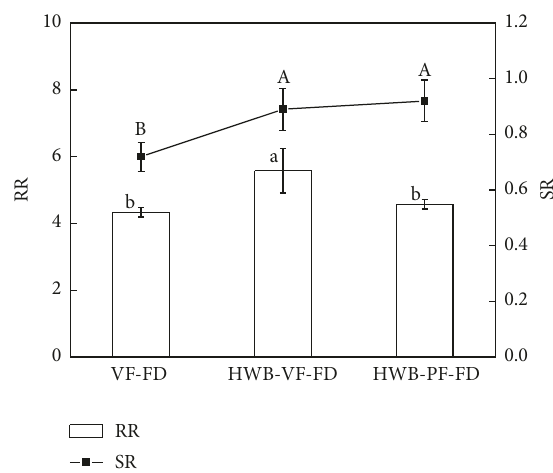
Figure 4: Rehydration ratio and shrinkage ratio of freeze-dried samples in 3 freeze-drying methods. VF-FD: apple samples without hot-water pretreatment were performed with vacuum freezing treatment and freeze-drying process; HWB-VF-FD: apple samples with hot-water pretreatment were performed with vacuum freezing treatment and freeze-drying process; HWB-PF-FD: apple samples with hot-water pretreatment were performed with plate freezing treatment and freeze-drying process. Note . Different letters on the same bar or line indicate significant differences at 𝑝 = 0.05 by Tukey’s HSD test.